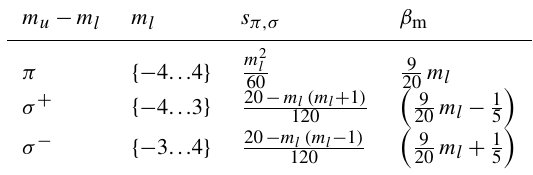
Table 4. Zeeman transitions characteristics for the O 2 line at 773.84GHz ( J : 4 → 4 and = 1). The relative strengths are normalized such as (cid:80) s π = (cid:80) s σ + = (cid:80) s σ − = 1 (Table 3.1 in Landi Degl’Innocenti and Landolfi, 2004). The frequency shift factors β m are from Eq.